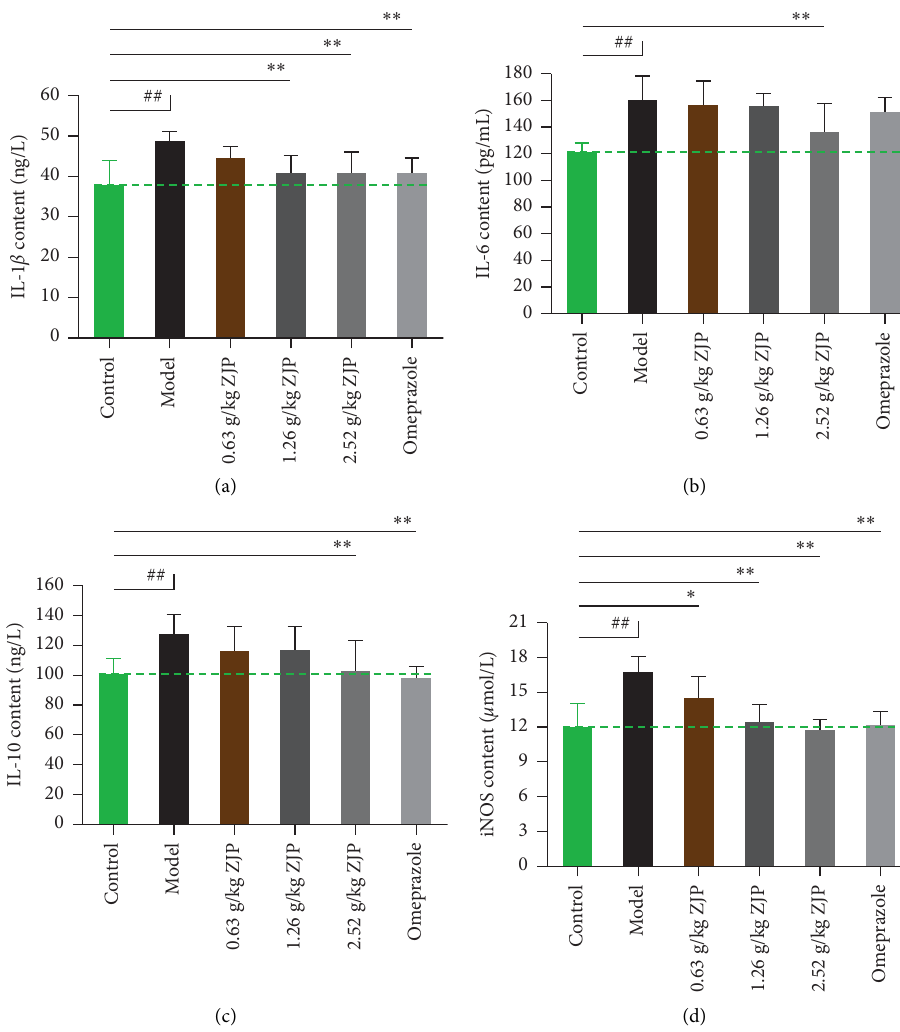
Figure 2: ZJP affects serum biochemical parameters (mean ± SD, n � 6). (a) IL-1 β content. (b) IL-6 content. (c) IL-10 content. (d) iNOS content. ## P < 0.01, compared with the control group. ∗ P < 0.05 and ∗∗ P < 0.01, compared with the model